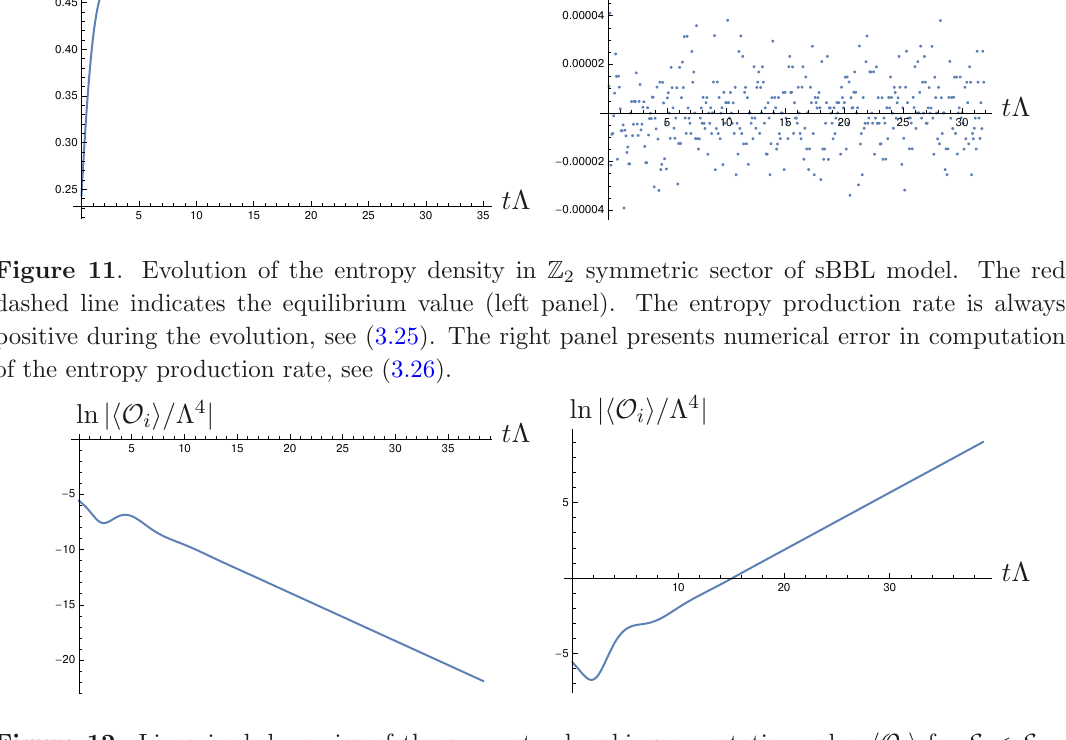
for < crit hO i i E E